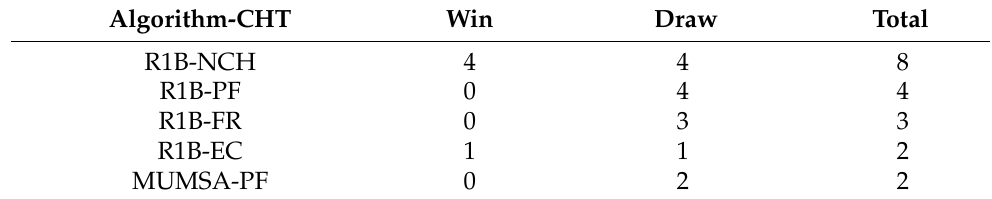
Table 15. Number of wins and draws in the overall performance of the most promising algorithms.